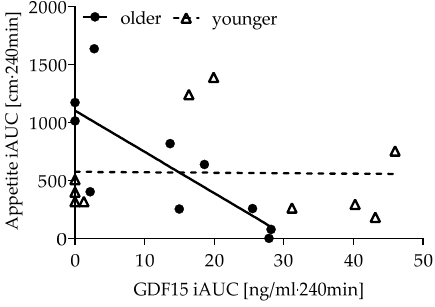
Figure 4. Correlation of appetite iAUC and GDF15 iAUC after dextrose ingestion in older (rho = − 0.802, p = 0.005) and younger women (rho = − 0.215, p = 0.550). iAUC: incremental area under the curve. Closed circles represent older women, open triangles younger women.